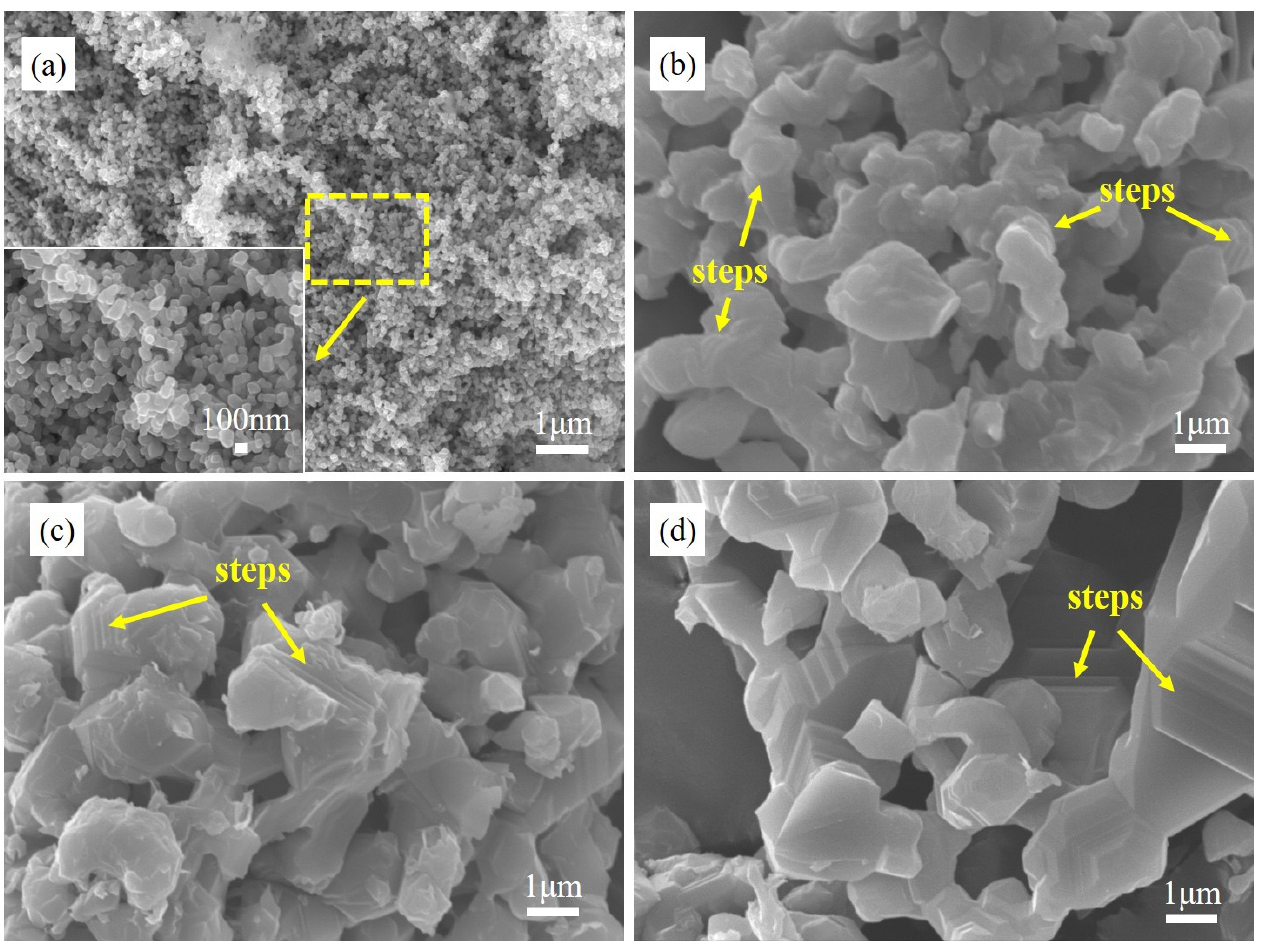
Figure 9. SEM morphologies of AlON synthesized at 1670 °C for various time:( a ) 30 min; ( b ) 1 h; ( c ) 2 h; ( d ) 4 h.